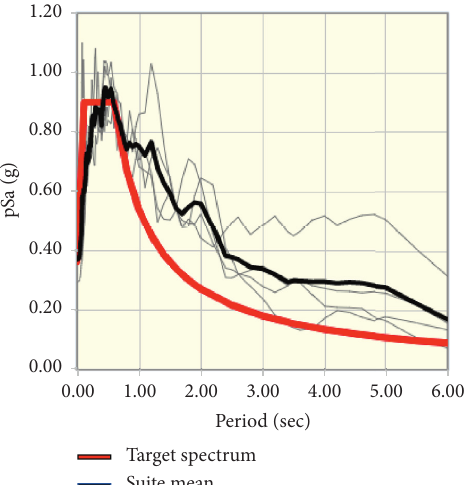
Figure 15: Scaling records to match the target spectrum [77].